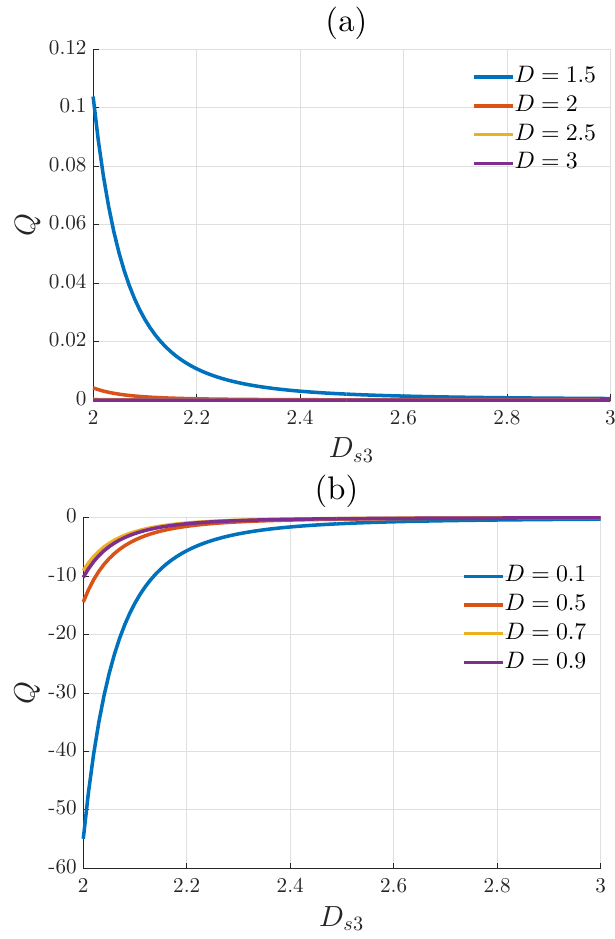
Figure 9. Plots of the fractal fluid discharge Q defined by Equation (35) with respect to the sur- face fractal dimension D s 3 for different values of the mass dimension D , for ( a ) 1 < D ≤ 3, and ( b ) 0 < D < 1. ∆ p = 25 Pa, µ = 10 − 3 Pa.s, and c = 100 m 1 − γ .